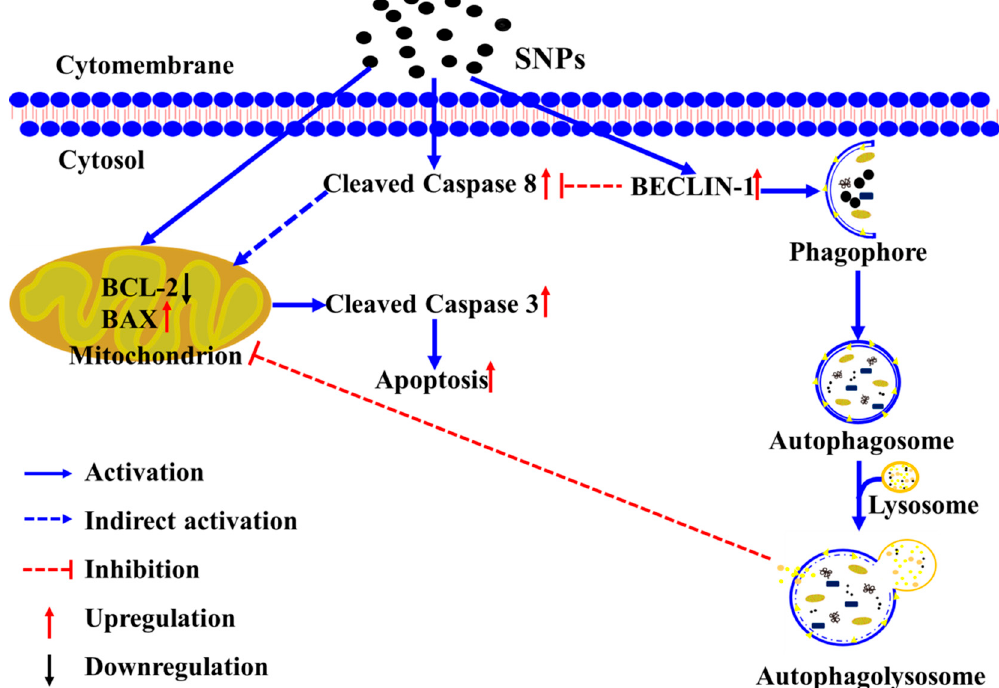
Figure 8. The schematic diagram of the signaling pathway involved in SNP-induced autophagy and apoptosis. and